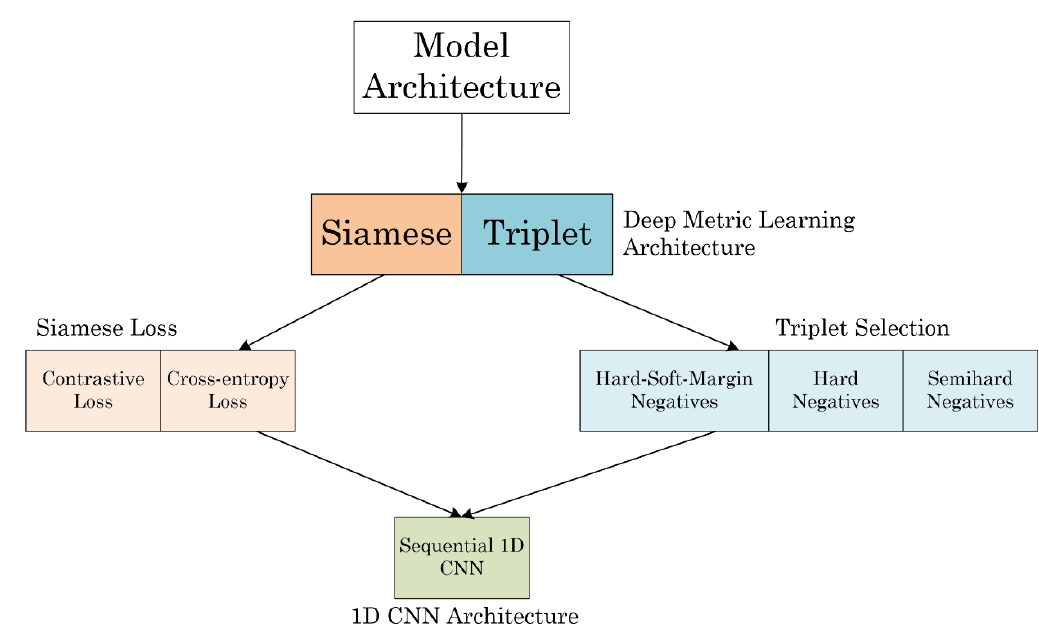
Figure 8. Model Configurations.